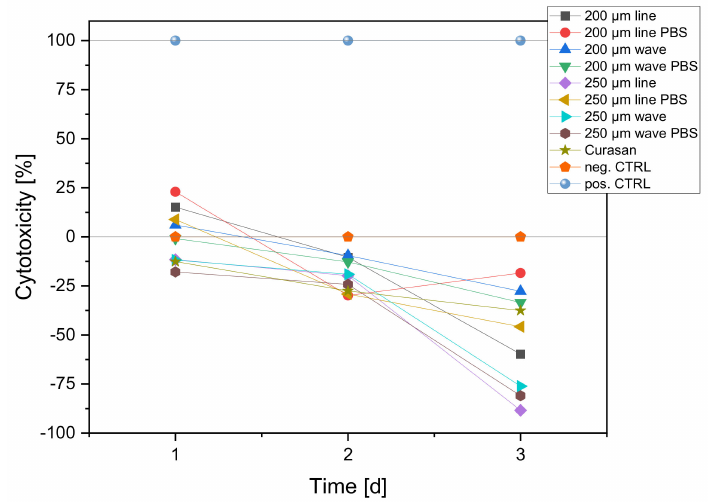
Figure 11. Cytotoxicity of the different scaffolds after 72 h. The positive control (pos. CTRL) was a 1% Triton X solution on cells, and the negative control (neg. CTRL) was cells. Curasan was the 3D cell culture